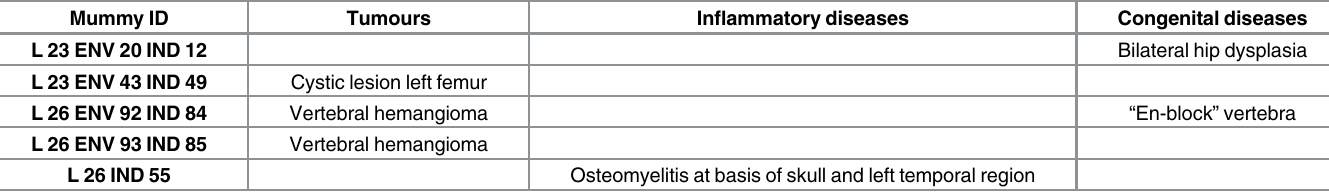
Table 2. Cases of congenital diseases, tumours and inflammatory